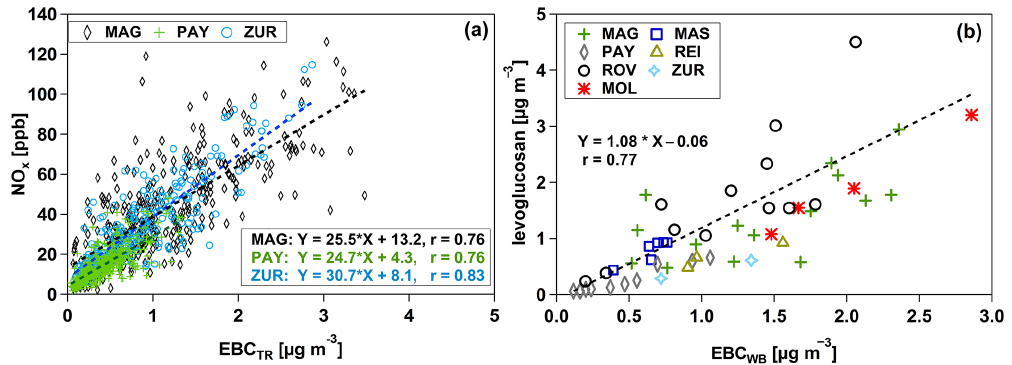
Figure 6. Comparison of the Aethalometer model outputs calculated with the α values ( α WB = 1.68 and α TR = 0.90) obtained by fitting Eq. (13) against EC F / EC with the additional traffic (NO x ) and wood-burning (levoglucosan) markers: (a) the correlation between EBC TR at 950nm and NO x averaged to 24h; and (b) the scatterplot between the EBC WB at 950nm and levoglucosan. Details of the origin of the data are given in Table 1.